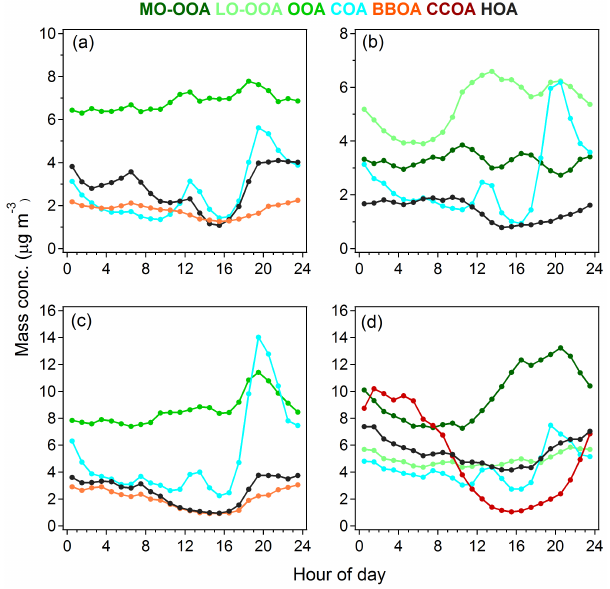
Figure 6. Diurnal variations in OA components in spring (a) , sum- mer (b) , autumn (c) , and winter (d)